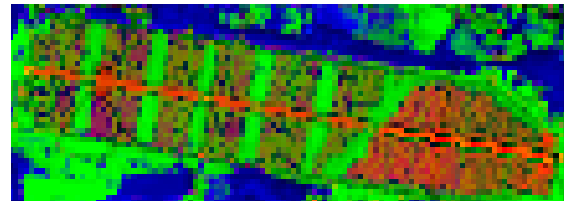
Figure 10: Sentinel-2 unmixing results. The PV abundance map is reported in red, while aggregates of other materials appear in blue and